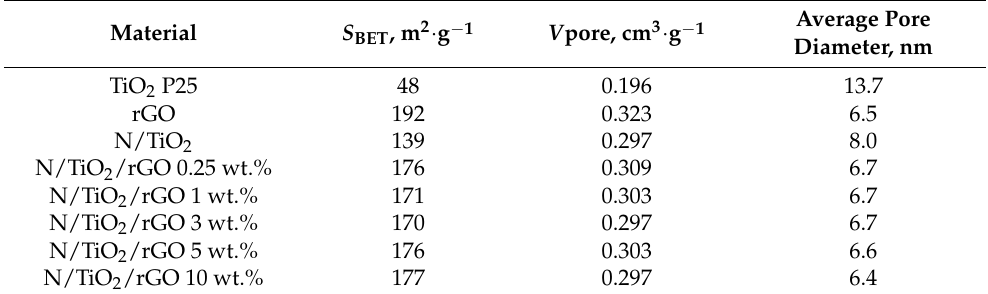
Table 1. Specific surface area, pore volume, and pore size of P25, N/TiO 2 , N/TiO 2 /rGO photocata- lysts, and rGO